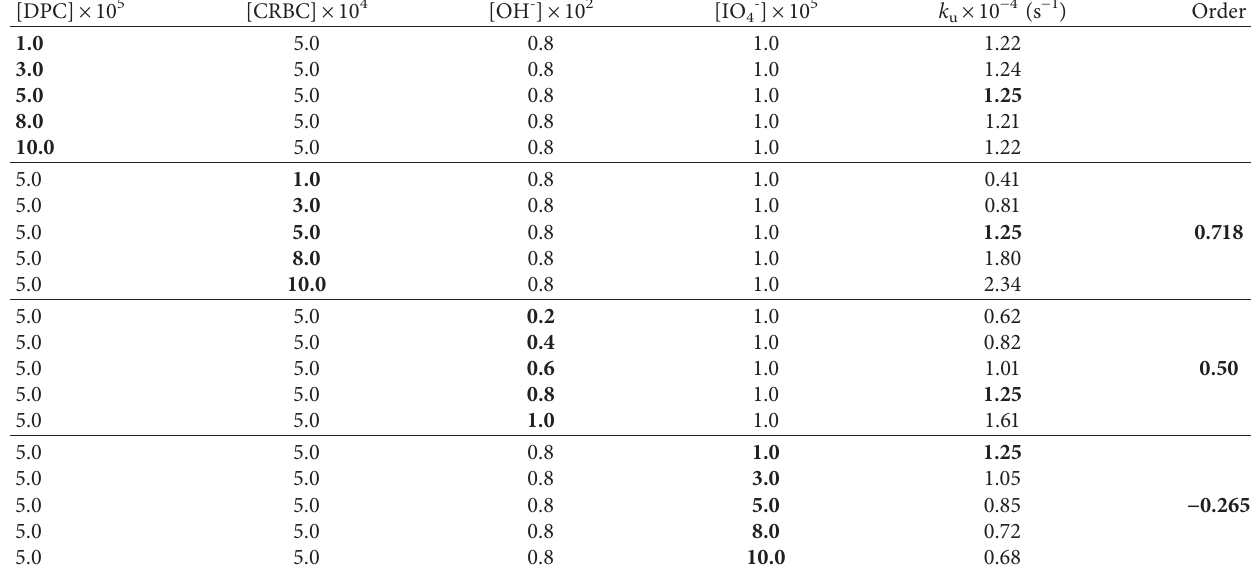
Figure 6: Order plot of log (abs) vs. time for the oxidation of CRBC by DPC Table 1: Effect of variation of [DPC] ∗ , [CRBC], and [KOH] on the oxidation of carbenicillin by diperiodatocuprate (III) in aqueous alkaline medium at 298K and I � 0.10/mol dm − 3 .